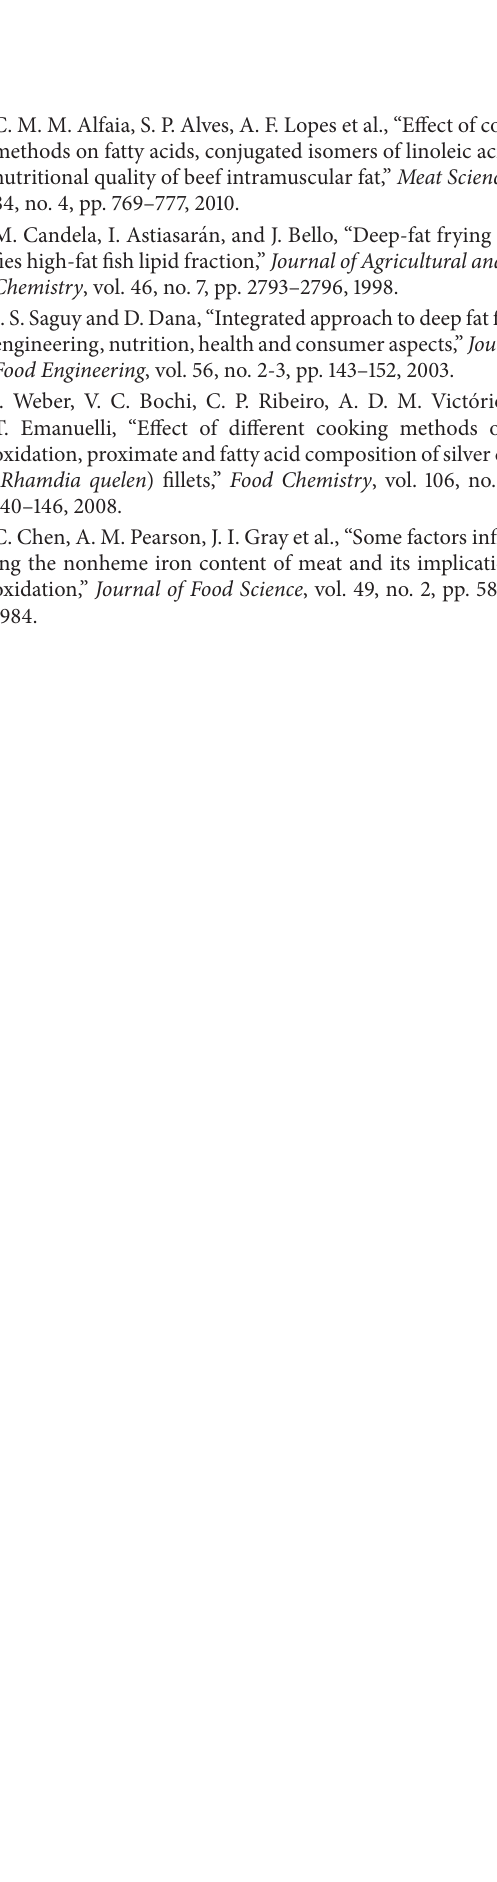
Table 3: Percentage of heme iron and nonheme iron to total iron in raw and cooked lamb meat.